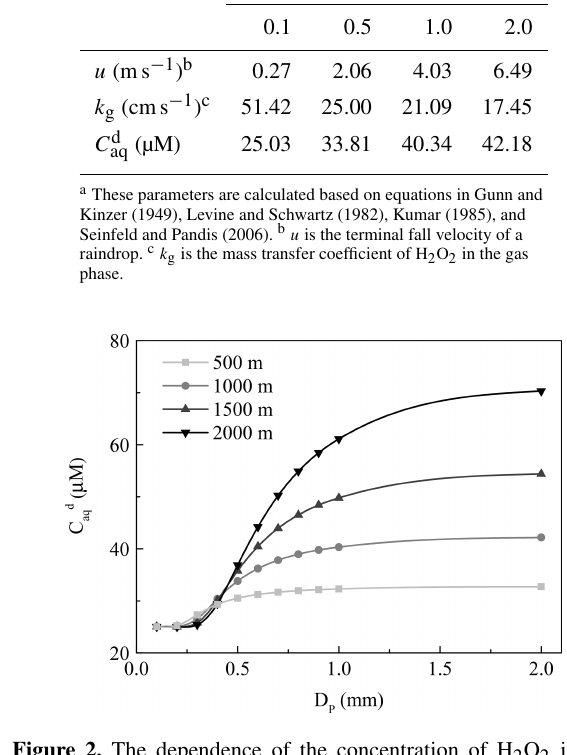
Table 1. Calculating the level of H 2 O 2 in the ground raindrops ( C d aq ) with different diameters ( D P ) from a height of 1000m a . Parameters